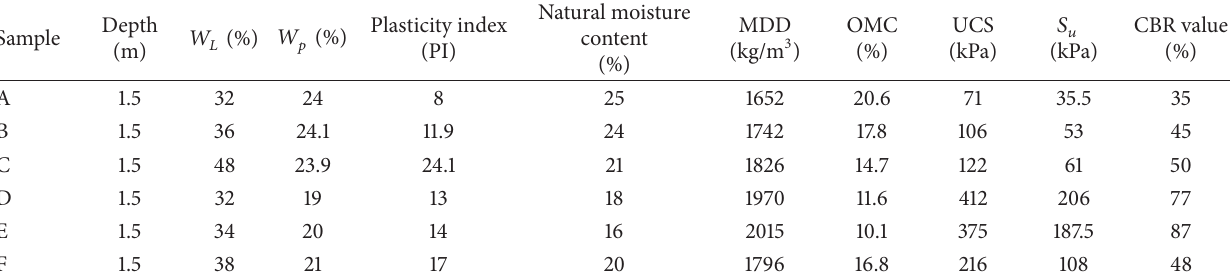
Table 1: Summary of geotechnical test results for the six